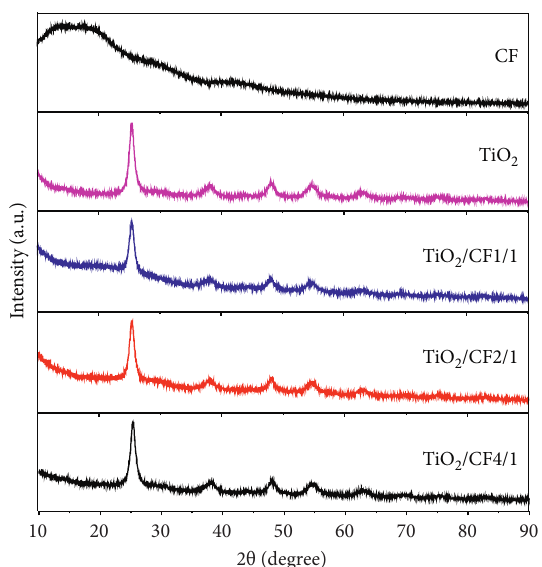
Figure 1: XRD patterns of TiO TiO 2 /CF